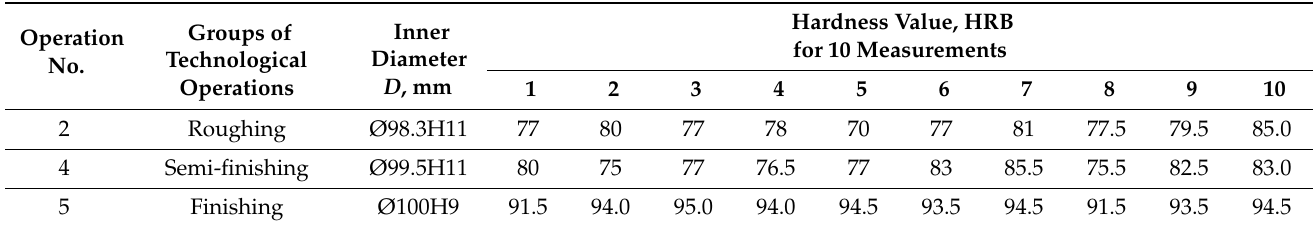
Table 4. Hardness value, HRB (for 10 measurements) on each technological